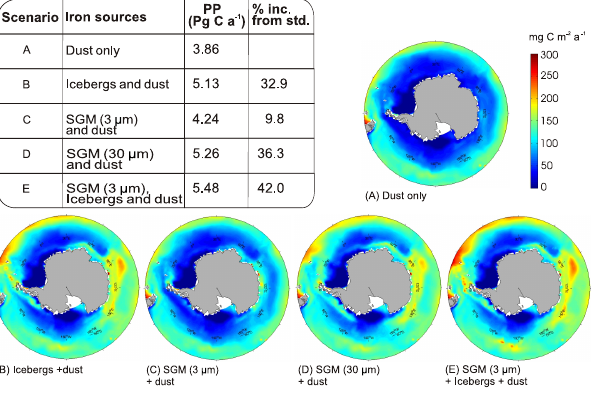
Figure 4. Modelled sensitivity of annual primary productivity of the Southern Ocean to external iron inputs. Tabulated total PP generated by the different model scenarios and polar stereographic images of annual primary productivity for model scenarios, (A) aeolian dust, (B) icebergs, (C) subglacial meltwater, SMW, where [Fe] = 3µM, (D) SMW, where [Fe] = 30µM and (E) aeolian dust + icebergs + SMW (where [Fe] = 3µM).